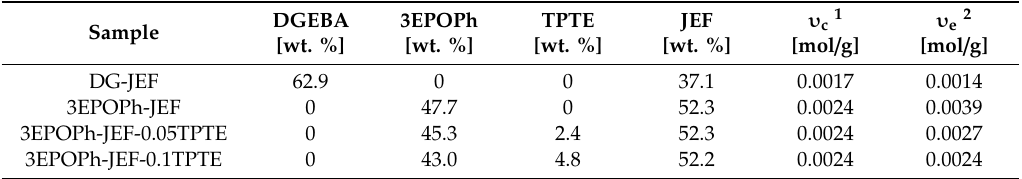
Table 1. Percentages in weight of epoxy monomers and crosslinking agent used in the preparation of the formulations.